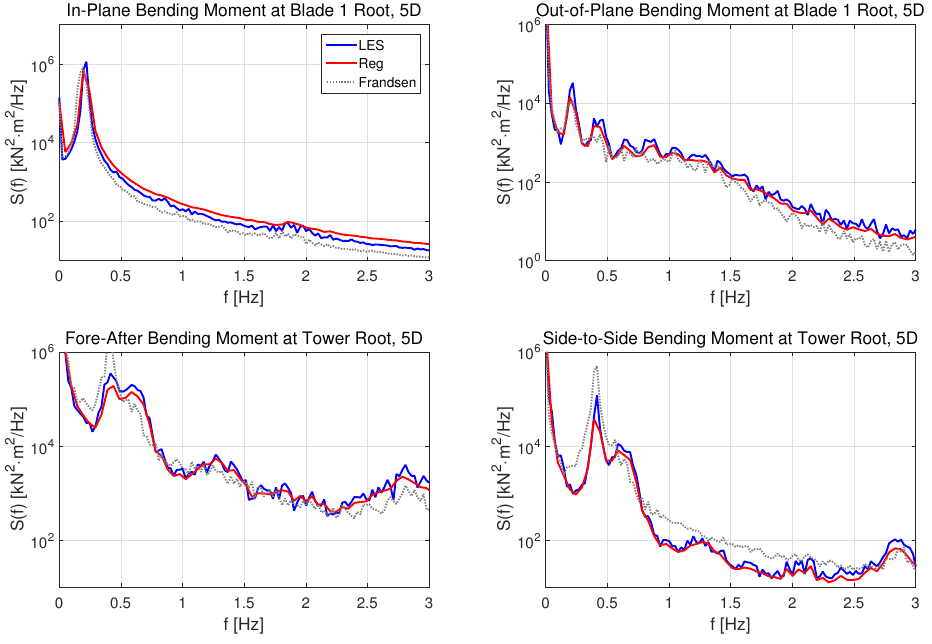
Figure 31. Power spectra of turbine loads in the wake at x = 5 D based on LES and the stochastic model.